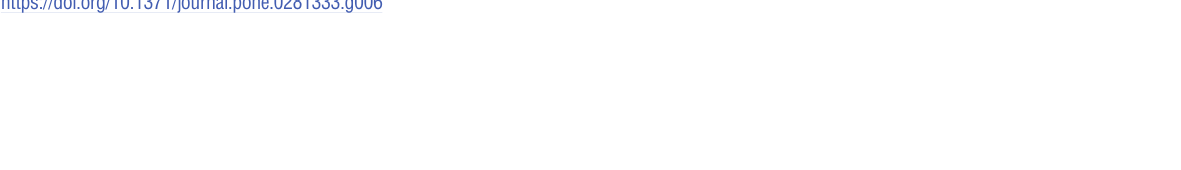
PLOS ONE | https://doi.org/10.1371/journal.pone.0281333 February 22,